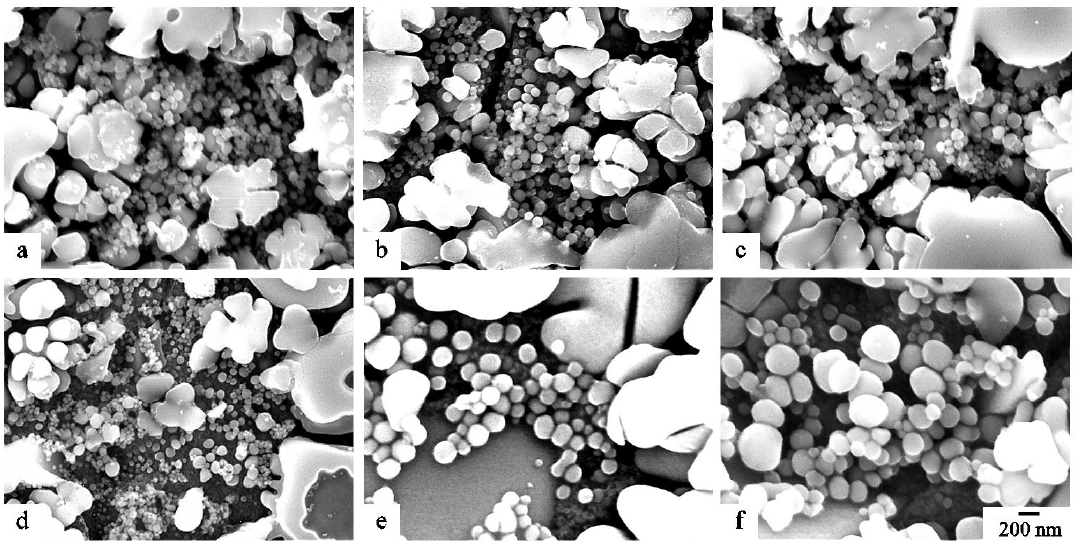
Figure 5. The pool of tertiary γ (cid:48) precipitates observed in the D2 ( a , d ), D4 ( b , e ), and D6 ( c , f ) alloys aged at 1123 K for 1 h ( a – c ) and 8 h ( d – f ).